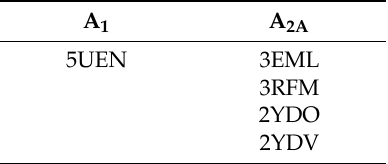
Table 1. Crystal structures of the adenosine receptors which can be used for drug discovery